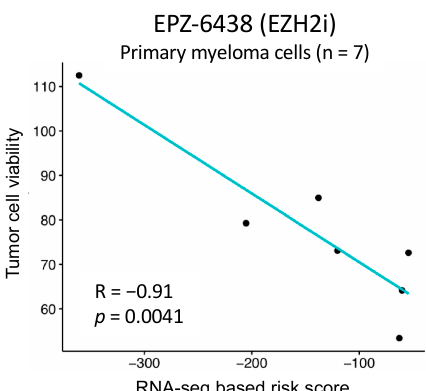
Figure 5. Correlation between RNA-seq-based risk score and response to targeted inhibitors. ( A ) Linear regression analysis of the inhibition ratio (treatment/control) of EPZ-6438, an EZH2 inhibitor, or the IC50 of three inhibitors of oncogene kinases (Aurora kinase inhibitor, MELKi, PBKi) in a function of the RNA-seq-based risk score in HMCLs. ( B ) RNA risk score predictions for EPZ-6438 sensitivity of primary patient myeloma cells. R represents the Pearson correlation coefficient (Pearson correlation test).